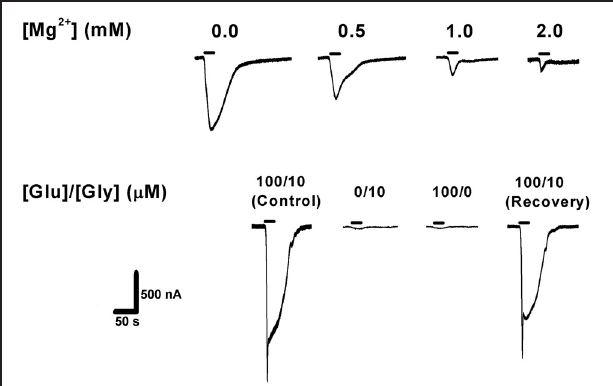
FIGURE 1 | Confirmation of NMDAR expression in Xenopus laevis oocytes. Top: increasing extracellular [Mg 2 + ] blocked NMDAR ionic current in a concentration-dependent manner (expected for all wild-type NMDARs). Bottom: activation of NMDAR requires simultaneous application of the co-agonists glutamate (100 µ M) and glycine (10 µ M), with no [Mg 2 + ] o added. Agonist application time was 20s (horizontal bars). GluN1-1b + GluN2B currents are shown as an example. The same measurements were performed with the other subunit combinations, confirming NMDAR currents in each